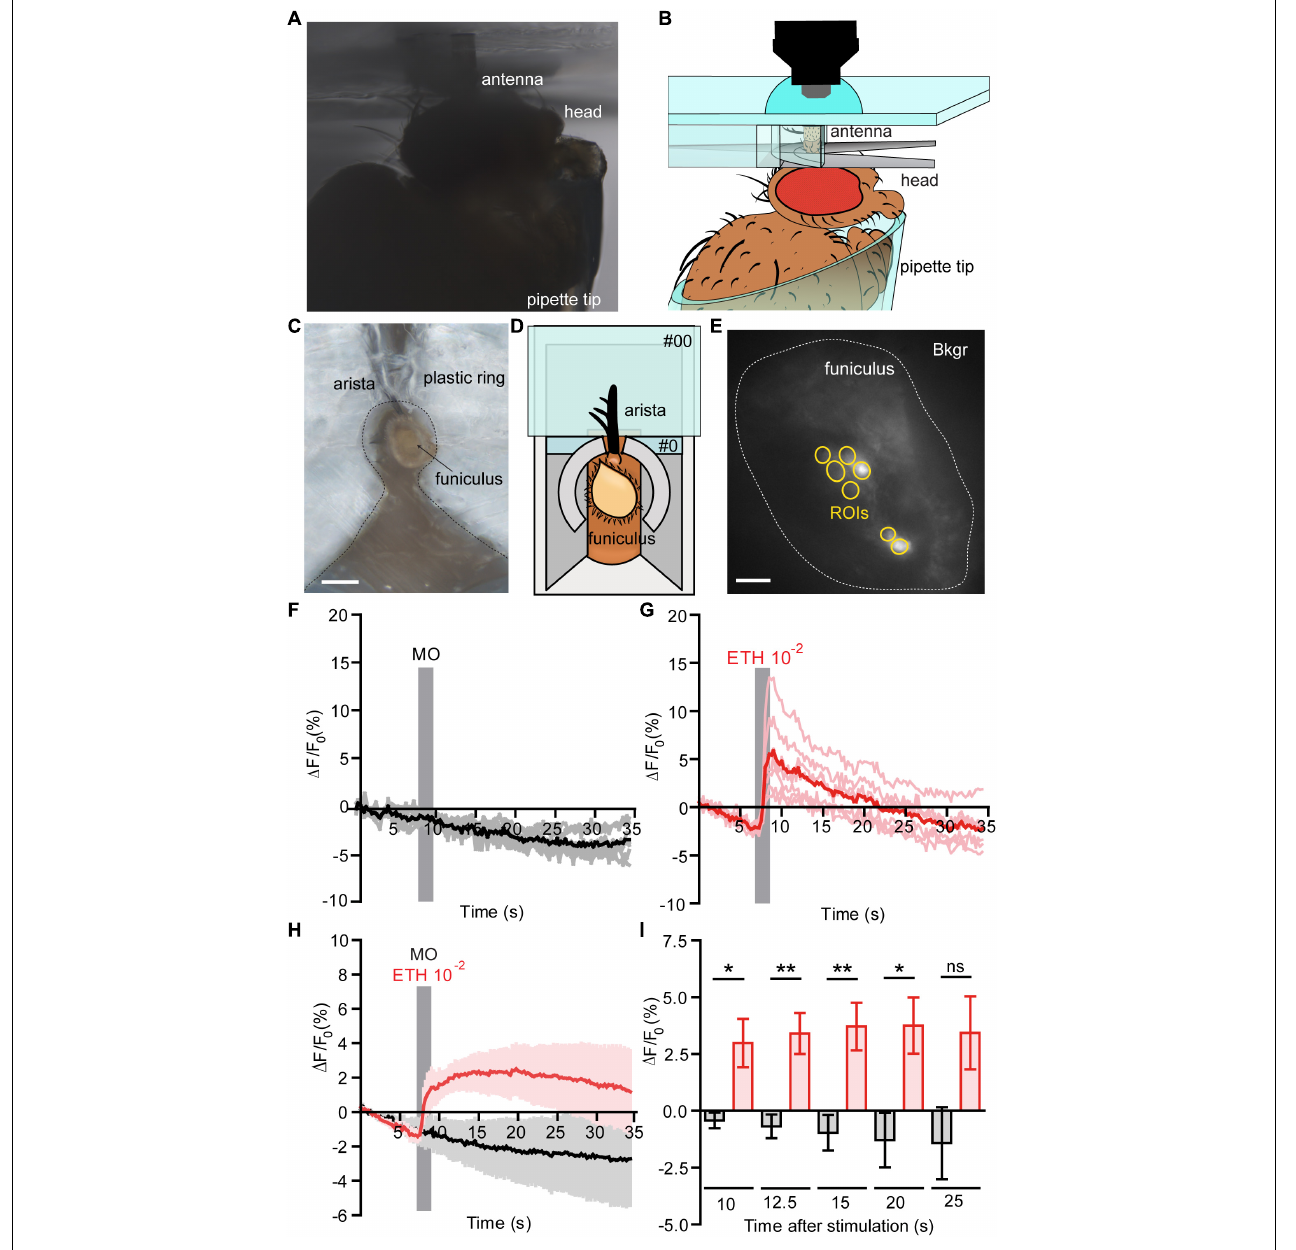
FIGURE 1 | Functional calcium imaging from an in vivo antennal preparation. (A) Image of the in vivo preparation from the side view. (B) Schematic representation of the fly placed in a pipette tip with it’s excised antenna held in vertical position on a custom holder, for the detailed information see Supplementary Figure 1 . (C) Image of the in vivo preparation from a top view, Scale bar = 0.5 mm. (D) Representation of the in vivo preparation from a top view, where open antenna is held within a #0 glass coverslip with support of an aluminum foil holder and a plastic ring around the antenna. A posterior slit on the plastic ring allowed fixing the arista directly on the #0 coverslip with odor-free glue. (E) Normalized fluorescence base level intensity from a fly preparation expressing GCaMP3.0 in Or22a olfactory neurons. The regions of interest (ROIs) are marked in yellow and the area used for the background subtraction (Bkgr) are marked in white, Scale bar = 10 µ m. (F,G) Example of the recorded fluorescence intensity (expressed in (cid:49) F/F0) over time from the same preparation as shown in (D) . (F) The fly was first stimulated with mineral oil (MO, negative control); the stimulus duration is marked with a vertical gray bar, each ROI as in (E) is represented in gray and the mean value in black. (G) The fly was then stimulated with ethyl hexanoate (EH) at a 10 − 2 dilution in mineral oil; the stimulus duration is marked with a vertical gray bar, each ROI as in (E) is represented in light red and the mean value in red. (H) Pooled responses from n = 5 antennae to MO (black) and EH 10 − 2 (red). Traces represents mean ± SEM. (I) Intensity of the responses to MO (black) and EH 10 − 2 (red) calculated subtracting the fluorescence value at the moment of stimulation (7 s) from the fluorescence intensity at a given time expressed in seconds after stimulation. The response to EH is long lasting and is statistically significant until 20 s after stimulation [correspondent to time = 27 s plotted in (G) ]. Paired t -tests, without multiple comparison correction, * p < 0.05, ** p < 0.01, ns, not significant. Graphs represent mean ± SEM. Statistics for each test is reported in the Supplementary Table 4 .